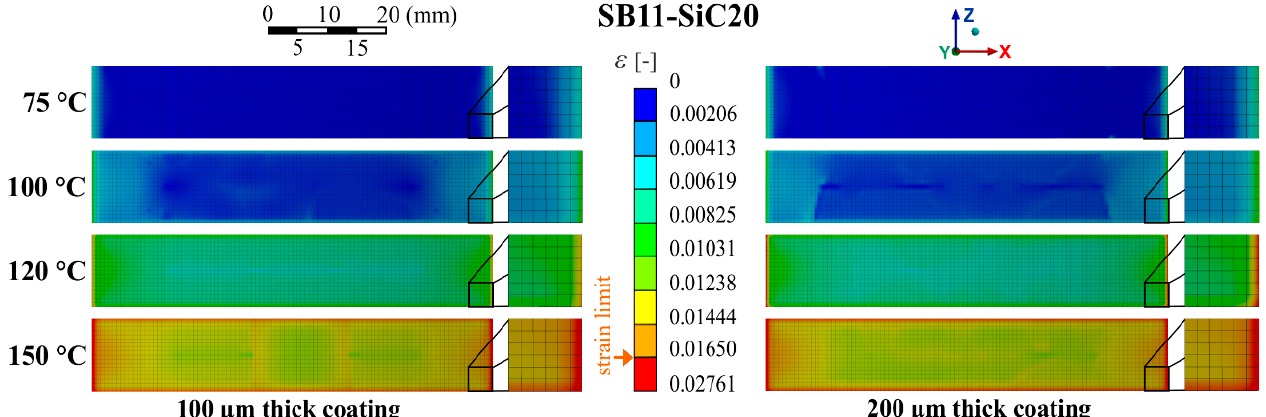
Figure 13. Distribution of the equivalent strain in the bottom composite coating surface (the surface in contact with Ag layer of the HTS tape) for the model with SB11-SiC20 coating of different thicknesses and quenching temperatures.